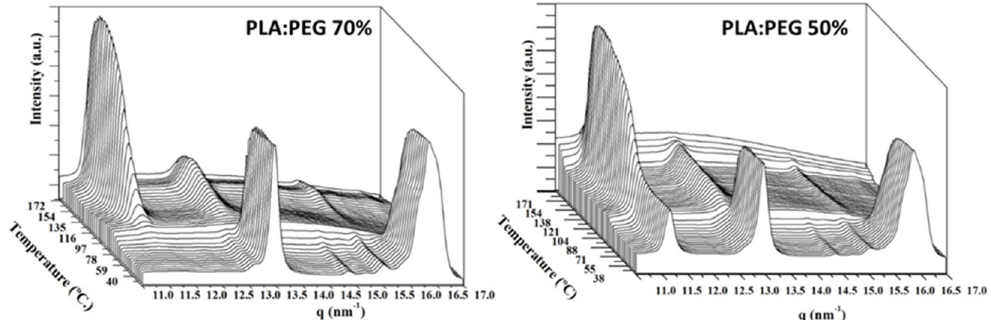
Figure 9. Three dimensional representation of WAXD profiles of representative micromolded PLA:PEG specimens having theoretical PLA contents of 70 wt-% (left) and 50 wt-% (right). Diffractograms were taken during heating scans at a rate of 10 °C/min from room temperature.